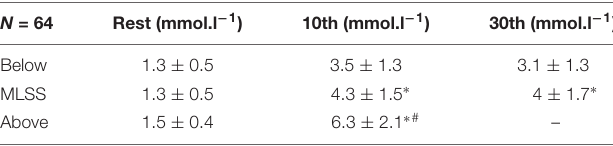
rats (except the intensity above MLSS).